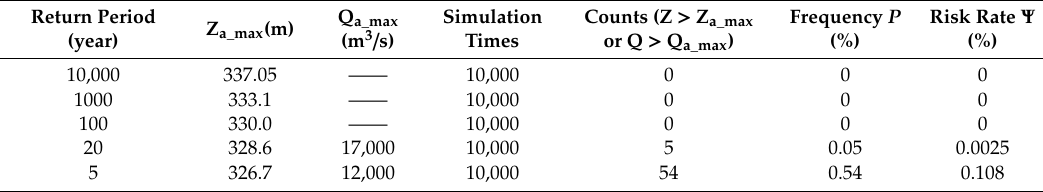
Table 4. The risk estimation results on CO for floods with di ff erent return